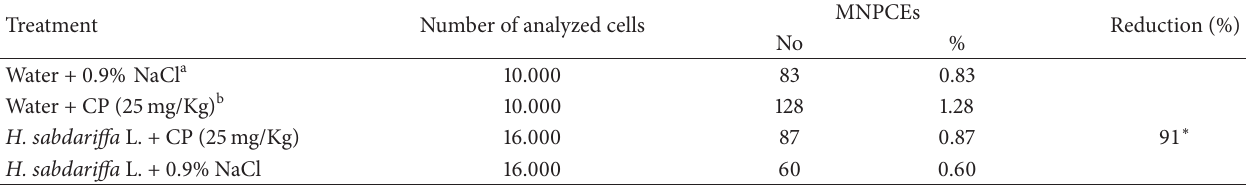
Table 1: The effect of H. sabdariffa L. on the frequencies of MNPCEs in the bone marrow after treatment with cyclophosphamide (CP). Treatment